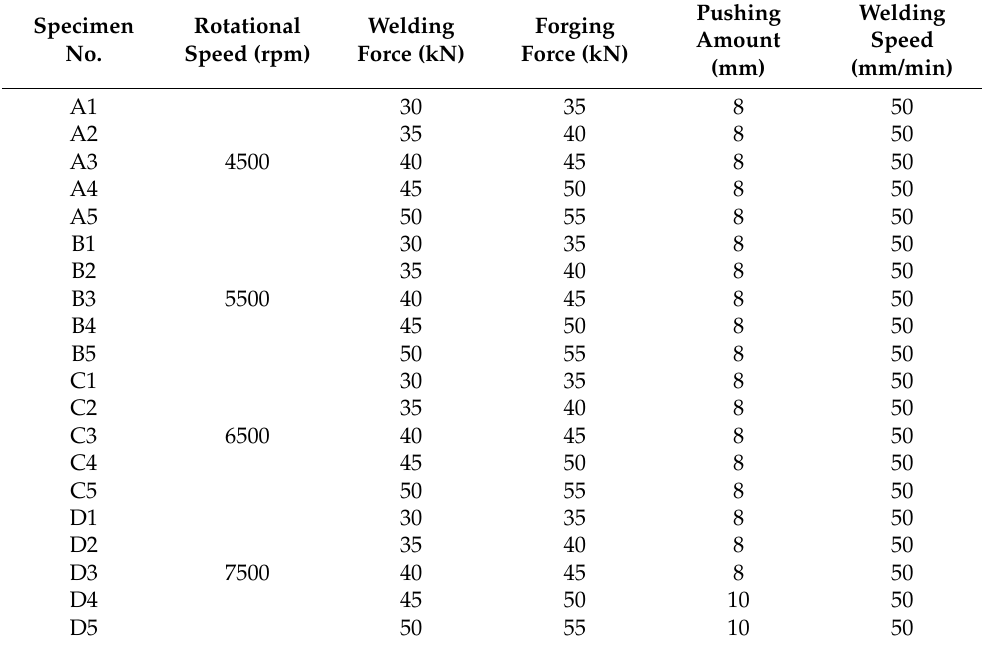
Table 2. Welding parameters and specimen no.